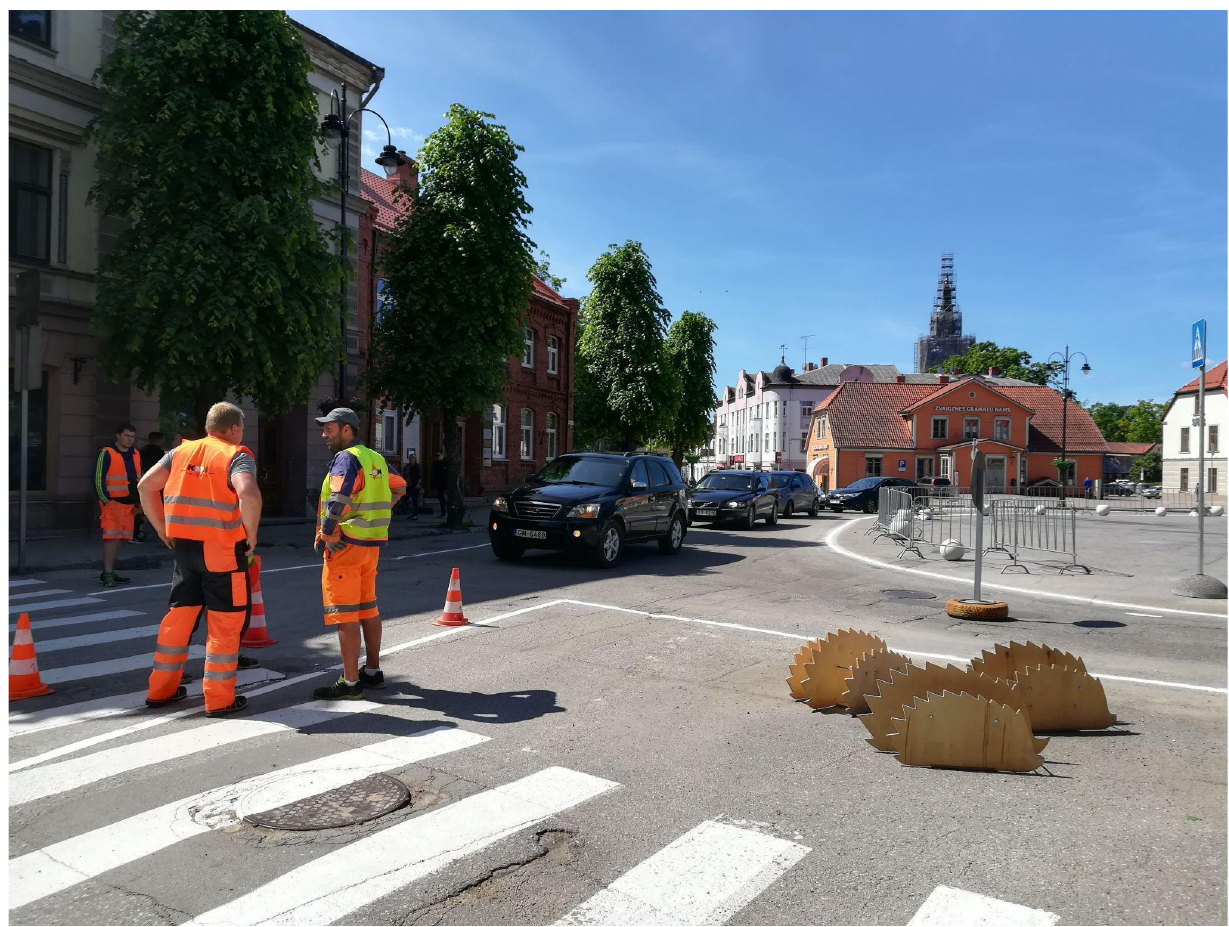
Figure 7. Cēsis Town: Realisation of the intervention at Vienības Square in 2019. online and on‐site survey was conducted to gather the opinions of the public on the changes, traffic safety, and potential functions and uses of the public